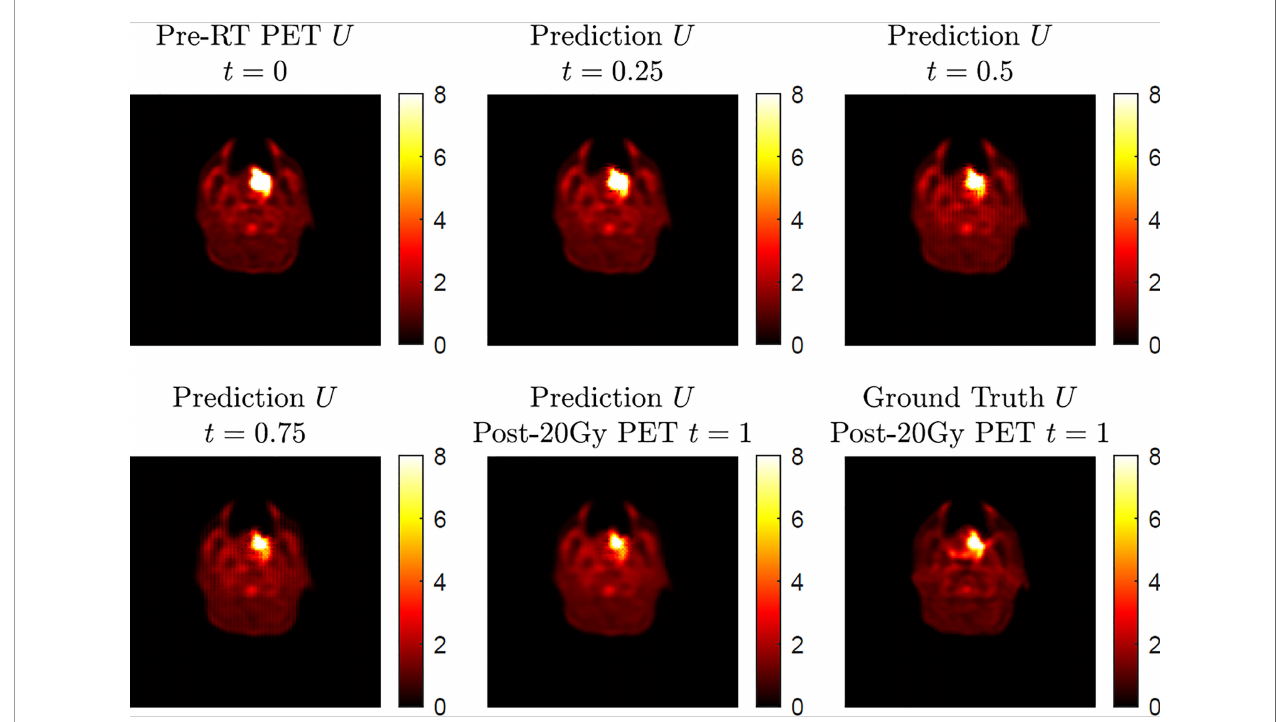
FIGURE 4 | A simulation of 18 FDG-PET image outcome transition based on a four-step execution with step size h = 0.25 showing the predicted transition from pre- radiation U at t = 0 to the predicted post-radiotherapy U at t = 1. The ground-truth post-20-Gy 18 FDG-PET image is included for comparison at t =